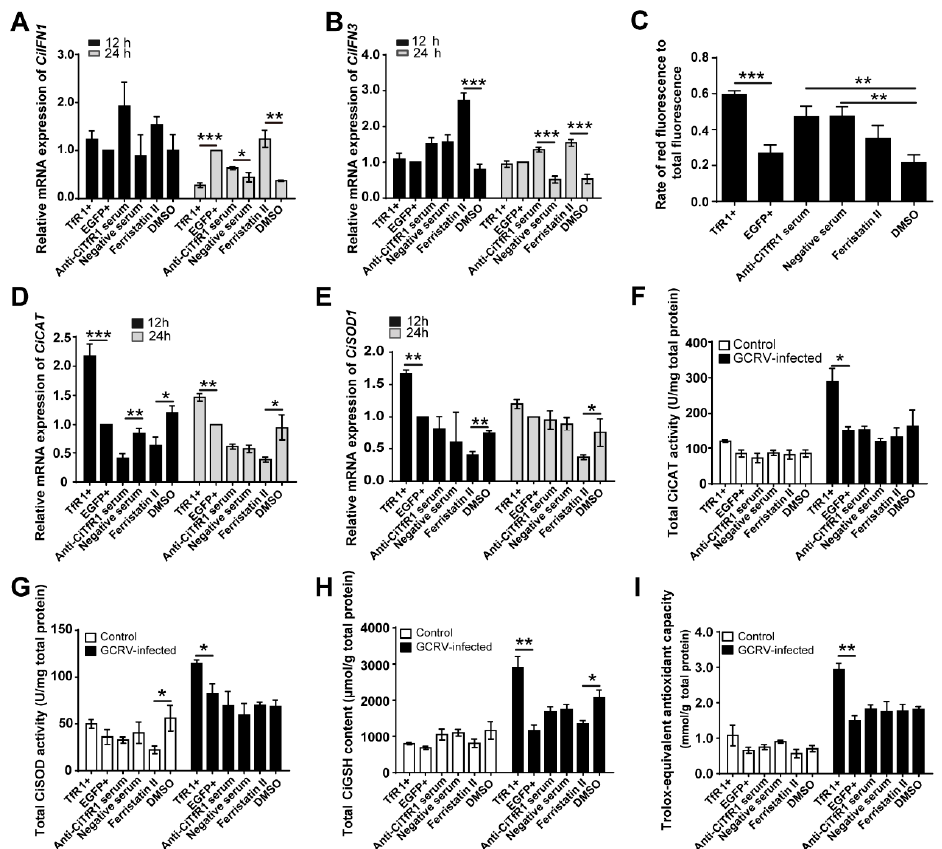
Figure 7. CiTfR1 inhibits the expression of CiIFN1 and CiIFN3 but enhances the intracellular oxidative stress upon GCRV infection. ( A , B , D – I ) Either TfR1 + , EGFP + , or CIK cells were equably seeded into 12-well plates for 24 h cultivation (1 × 10 6 /well), and then CIK cells were treated with DMSO, Ferristatin II, 1% anti-CiTfR1 serum or negative serum, respectively. Twelve hours later, all the cultivated cells were infected with GCRV (MOI = 1). Cells were harvested at 12 h and 24 h p.i. for detection of relative mRNA expression of CiIFN1 ( A ), CiIFN3 ( B ), CiCAT ( D ), and CiSOD1 ( E ). Data are presented in relative expression units where EF1 α was used to normalize all samples. Cells were harvested for the detection of total cellular CAT ( F ) and SOD activities (G), Trolox-equivalent antioxidant capacity ( H ), and total GSH content ( I ) at 12 h p.i. ( C ) Superoxide anion in differently treated cells was assessed by using DHE method at 12 h p.i. DHE that emits blue fluorescence indicates the total intracellular DHE; ethidium that emits red fluorescence indicates the intracellular superoxide anion. The rate of red fluorescence to the total fluorescence represents the relative amount of intracellular superoxide anion. Data represent mean ± SD of three independent experiments. * p < 0.05, ** p < 0.01, *** p < 0.001.